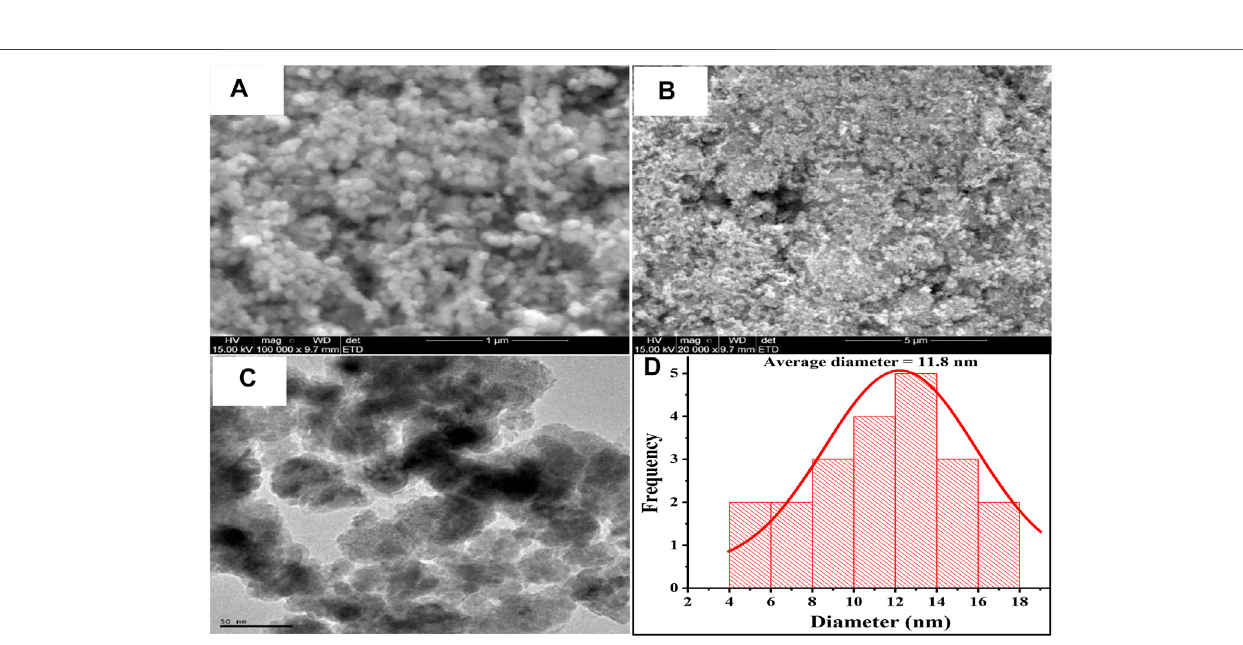
Frontiers in Sensors |